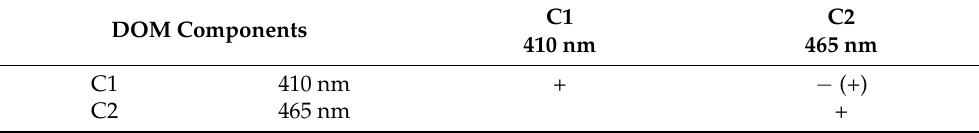
Table 7. The change order table of DOM components with time as disturbance factor in AI.